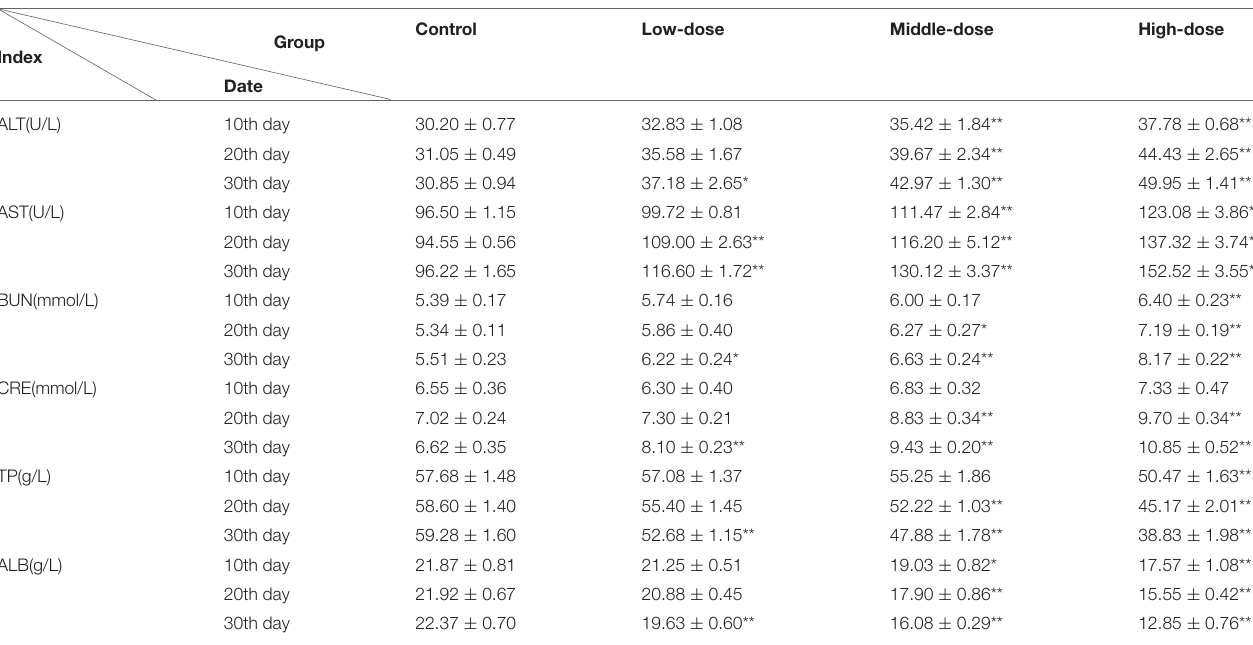
TABLE 3 | Biochemical marker characterization of aconitine-treated mouse.